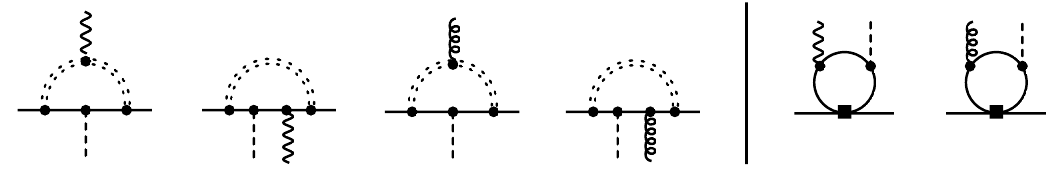
Figure 1 . Left panel: one-loop diagrams contributing to fermion (chromo-)EDMs in the full theory including dynamical leptoquarks. Right panel: one-loop diagrams contributing to fermion (chromo-)EDMs in the EFT where leptoquarks have been integrated out. Solid lines denote SM fermions, single dashed lines the Higgs (cid:12)eld, double dashed lines leptoquarks, wavy lines photons, and curly lines gluons. Circled vertices denote vertices of dimension four, while squares denote e(cid:11)ective vertices arising from higher-dimensional operators. Only one topology for each diagram is